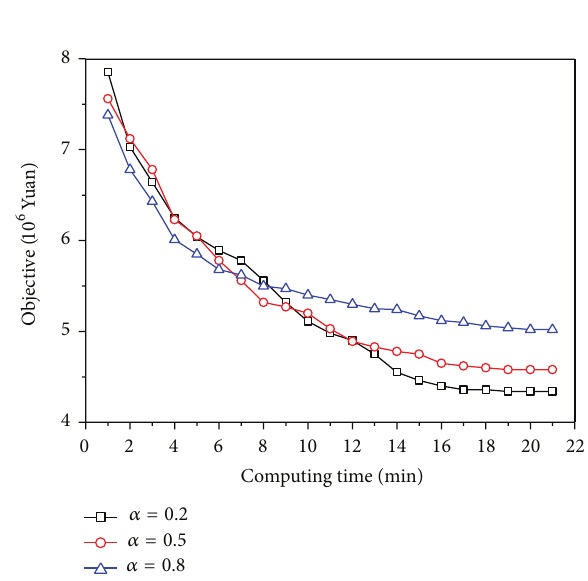
Figure1:Convergenceofthesolutionwithdifferentvaluesofweight para 𝛼